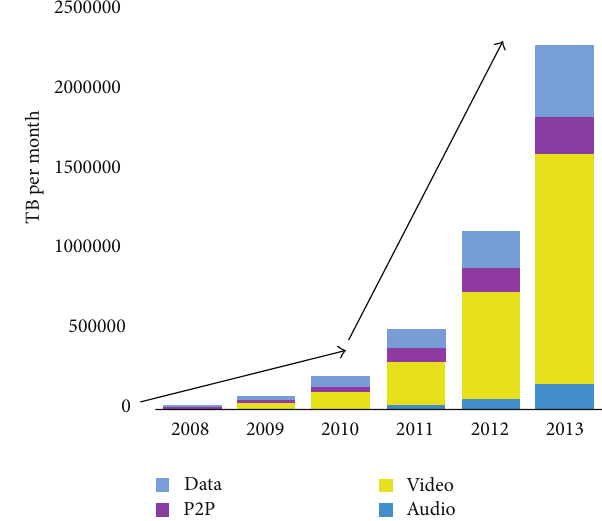
Figure 5: Mobile device bandwidth trend.